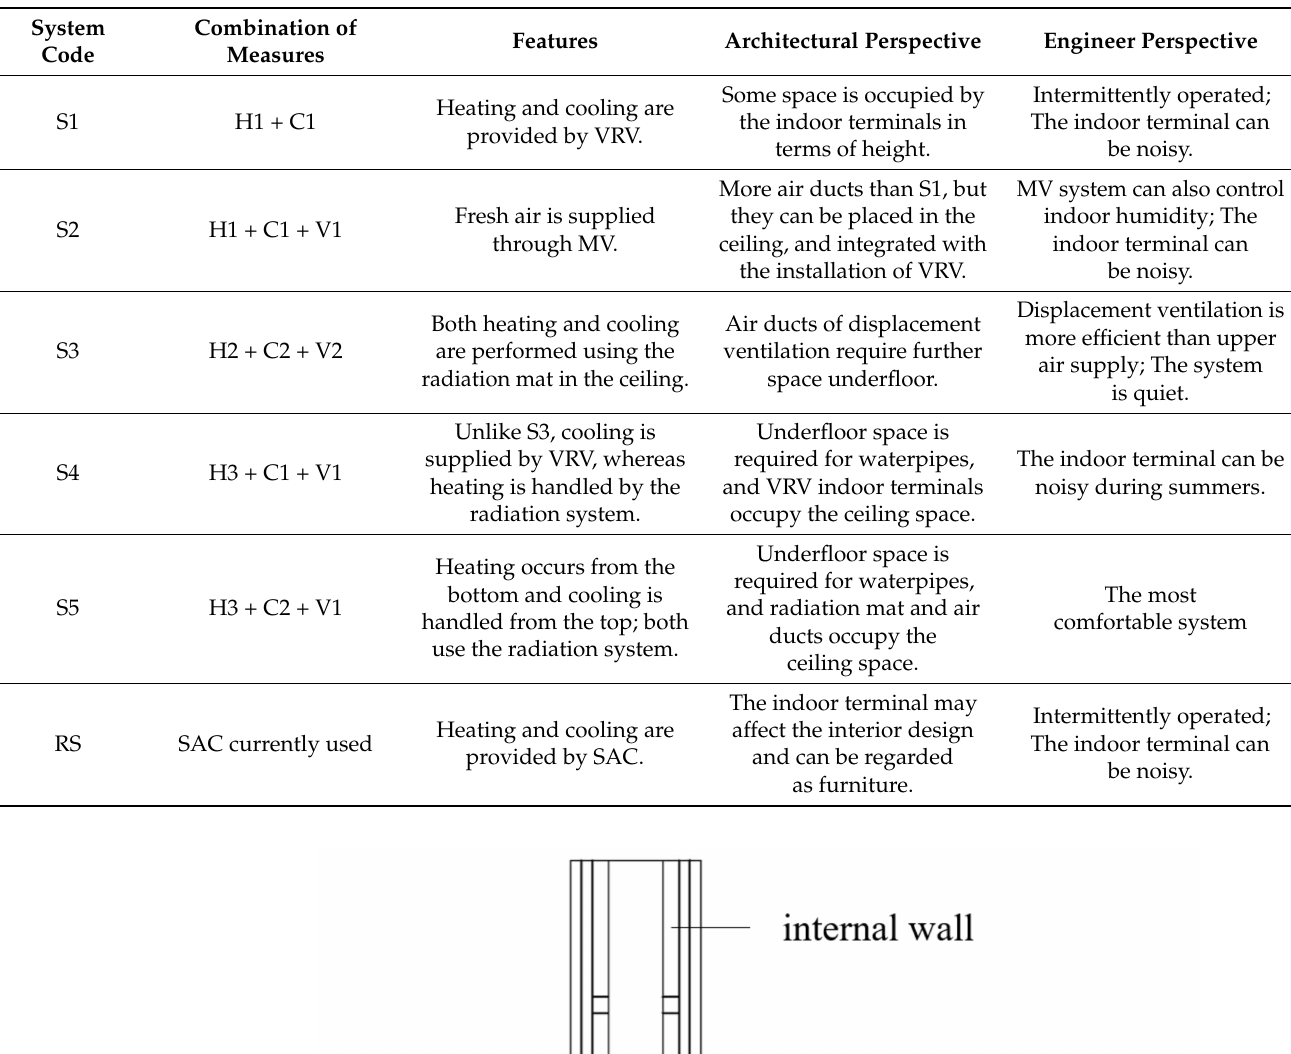
Table 5. Potential air-conditioning systems in Shanghai.